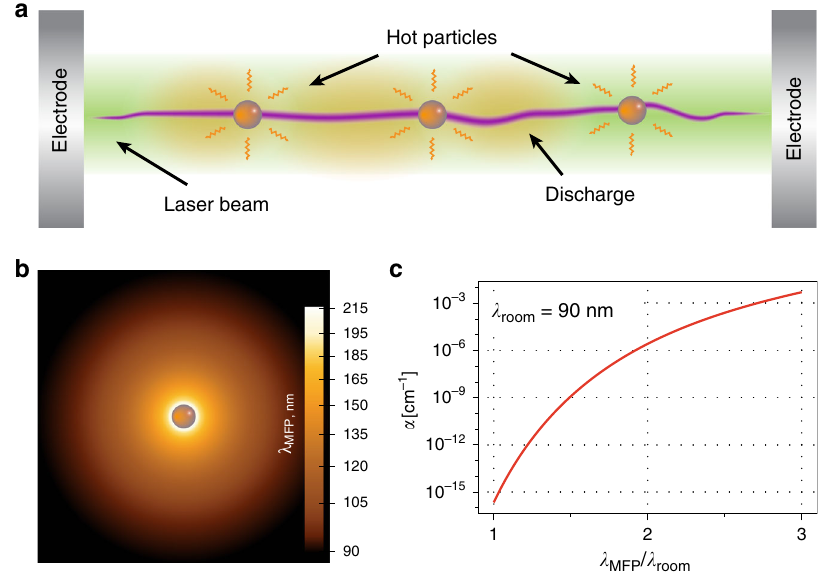
Fig. 1 Mechanisms for a laser-induced air breakdown and discharge guidance. Laser vortex beam that traps particles and at the same time heats them ( a ) leading to the local reduction in the air density and the increase of the electron mean free path λ MFP in heated regions surrounding the particles ( b ). This dramatically increases the Townsend ionisation coef fi cient α ( c ) in hot areas resulting in a decrease of the discharge